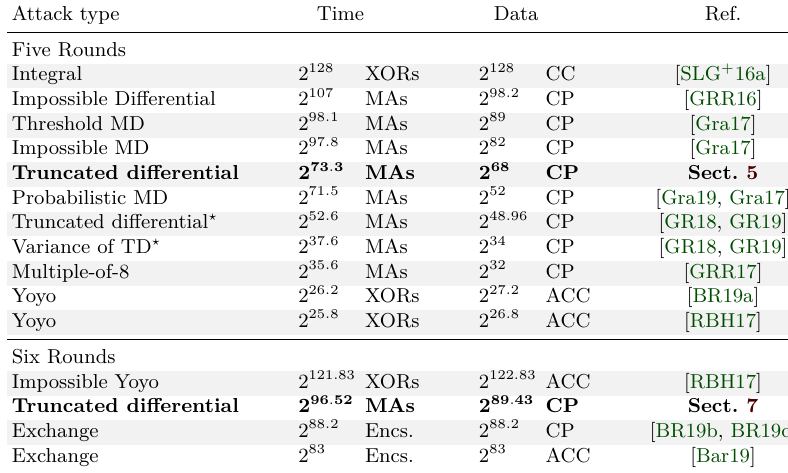
Table 1: Existing secret-key distinguishers on five and more rounds of the AES -128, ordered by rounds (descending) then time (ascending). MAs = memory accesses; Encs. = r -round AES encryptions; CP = chosen plaintexts; (A)CC = (adaptive) chosen ciphertexts; MD = mixture differential; TD = truncated differential. ? : We employ the updated parameters from [GR19]. The original distinguishers had been proposed in